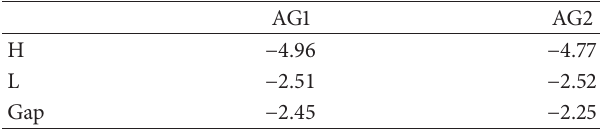
Table 2: Energy levels of HOMO and LUMO and energy gap (eV).